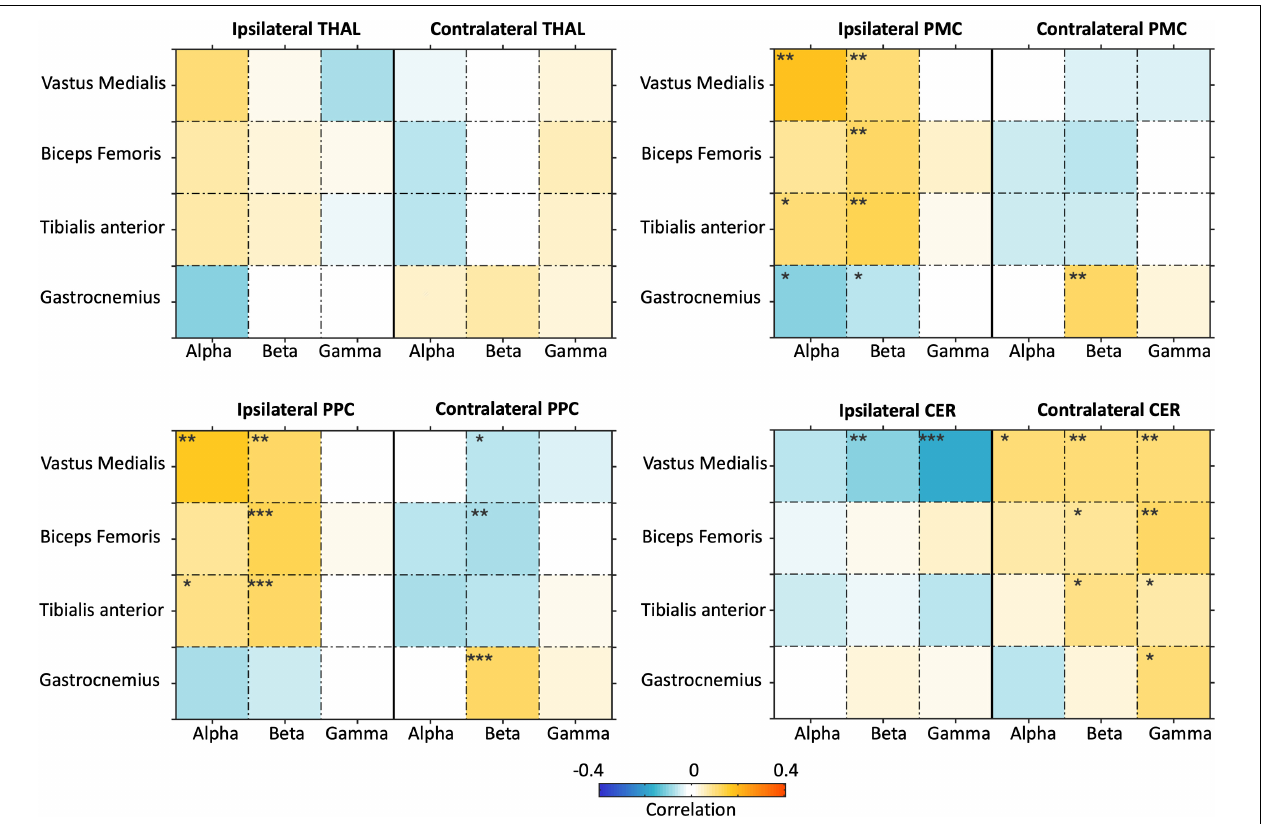
FIGURE 9 | Analysis of brain-body connectivity for ipsilateral and contralateral thalamus (THAL), premotor cortex (PMC), posterior parietal cortex (PPC), and cerebellum (CER), in alpha, beta, and gamma frequency bands. The brain-body connectivity is assessed using envelopes of reconstructed neural signals and EMG envelopes. *p FDR < 0 . 05 ; **p FDR < 0 . 01; ***p FDR < 0 .